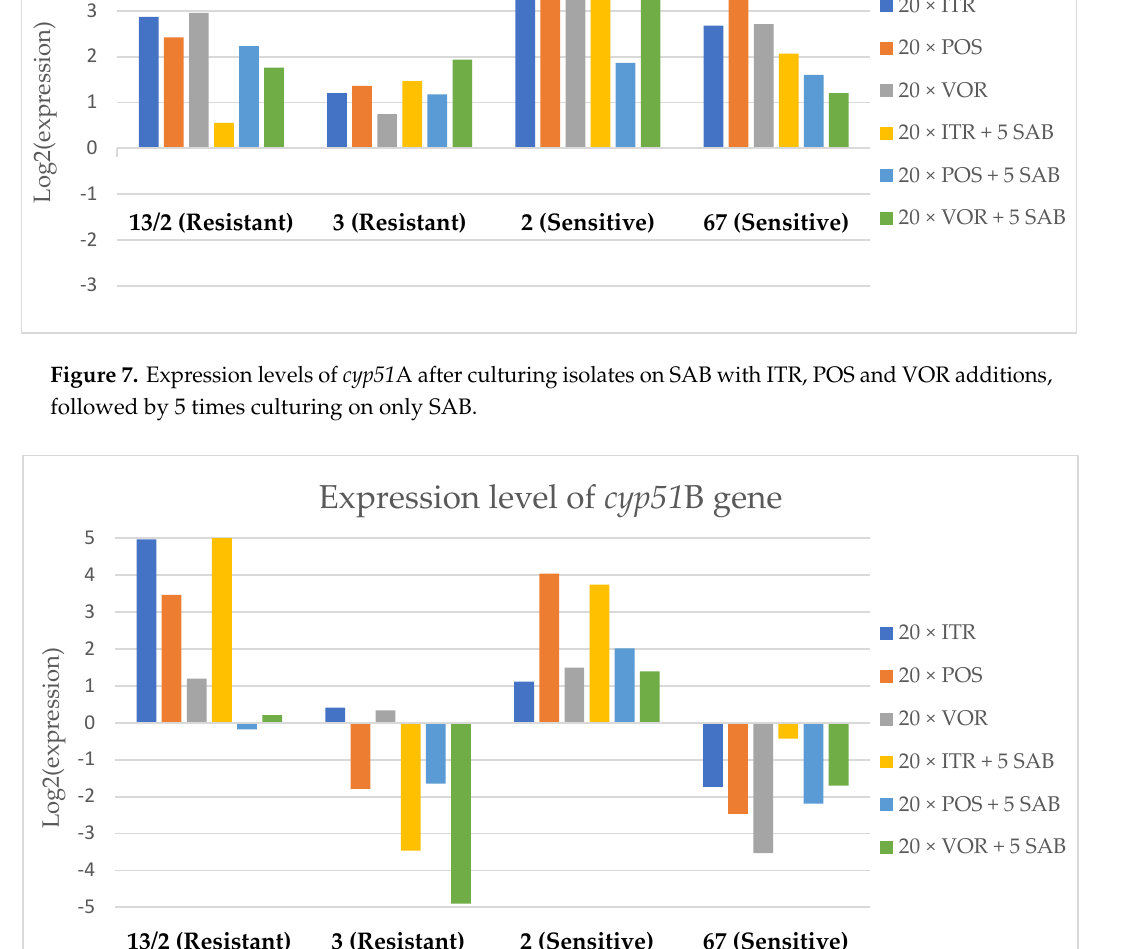
Figure 8. Expression levels of cyp51B after culturing isolates on SAB with ITR, POS and VOR additions, followed by 5 times culturing on only SAB.